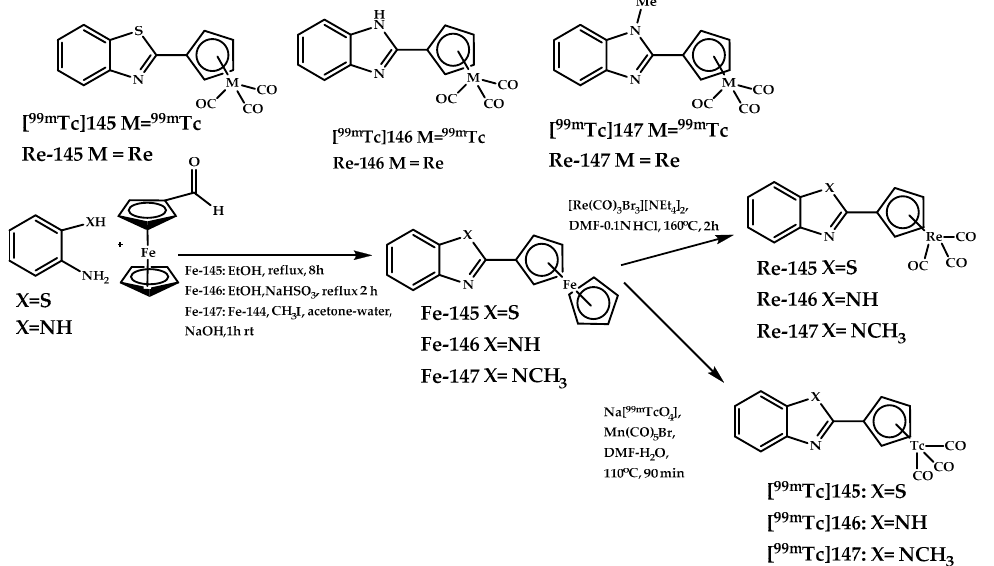
Figure 34. 99m Tc complexes [ 99m Tc]145– [ 99m Tc]147 and their corresponding Re analogues 145 – 147 designed for SPECT imaging of A β plaques